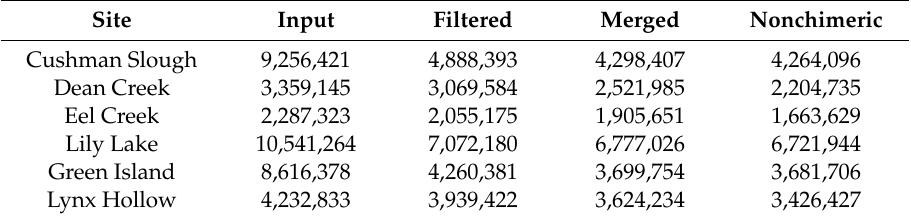
Table 2. Stepwise number of reads in each population after each step during DADA2 processing of 16S bacterial sequence